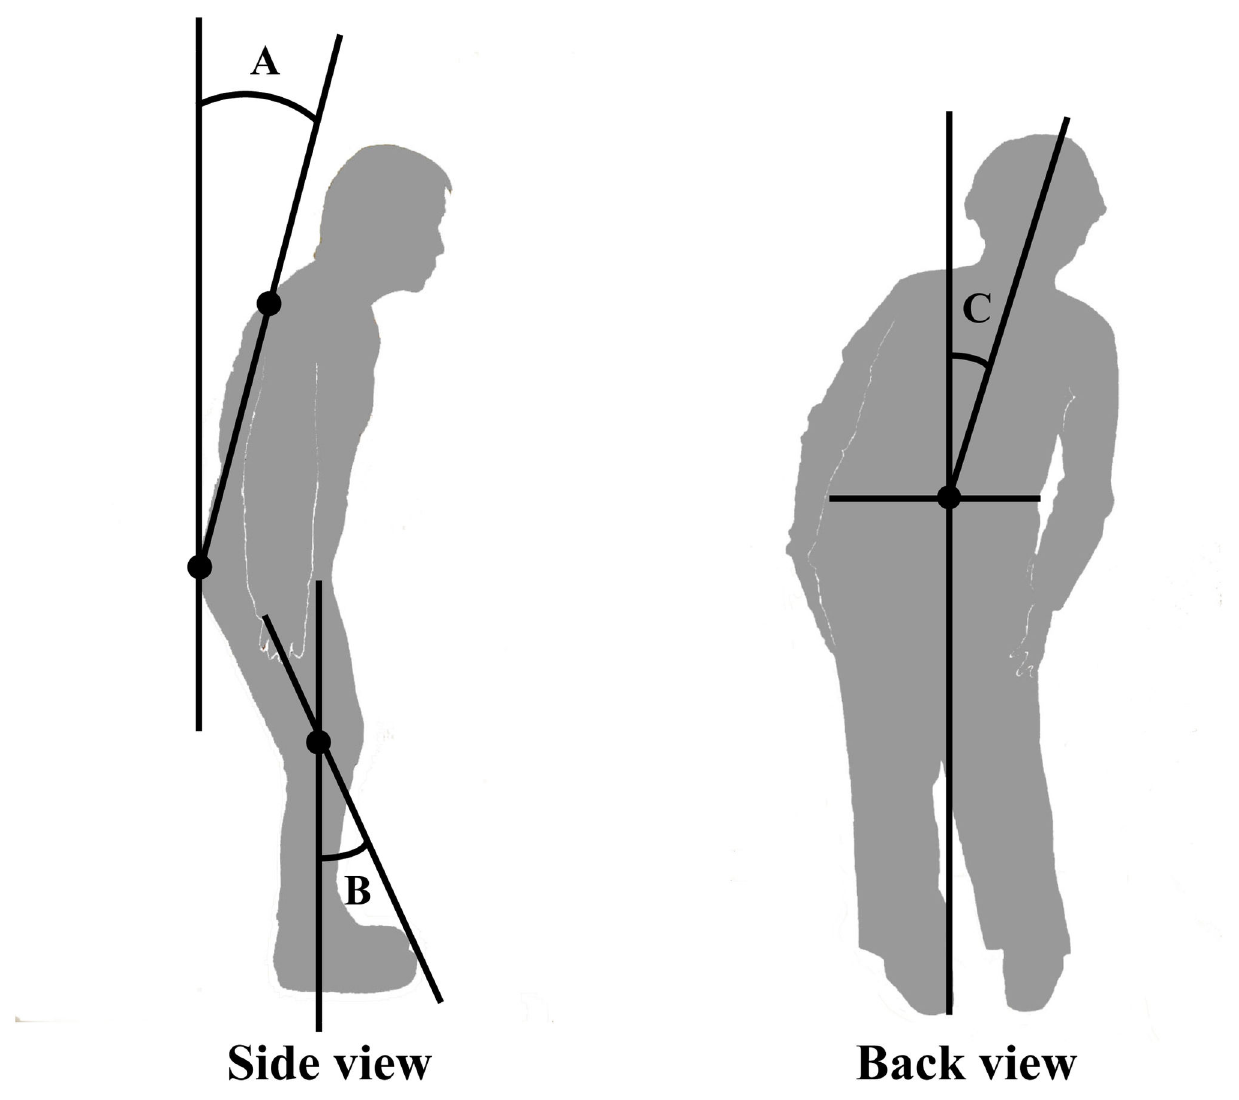
Figure 1. Measurements of postural abnormality in PD. Evaluations of bent spine and knee and the Pisa sign (lateral bending) are determined by the angle of the intersection of the basic axis and the movement axis. (A) Assessment of bent spine from a lateral view: (basic axis), a perpendicular line on the ground goes along the rear portion of the 5th lumbar vertebral body (movement axis), and a rear line links the 1st thoracic vertebral body to the 5th lumbar vertebral body. (B) Assessment of bent knee from the lateral view: (basic axis). The line passes along the center of the femoral bone (movement axis) and a median line links the lateral malleolus of the leg to the knee. (C) Assessment of the Pisa sign from the back view: (basic axis), a perpendicular line on the ground passes through the midpoint of the Jacoby line (movement axis) and a line links the 1st thoracic vertebral body to the midpoint of the Jacoby line. doi: